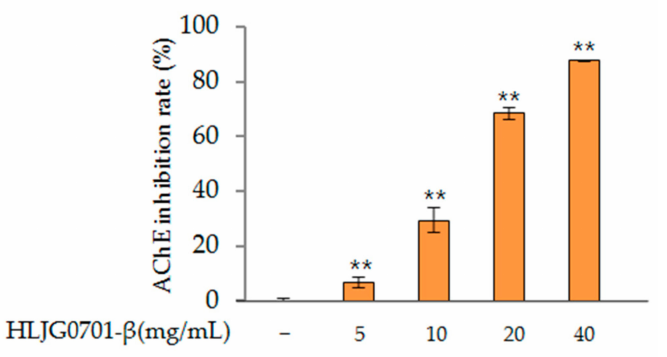
Figure 2. AChE inhibition rates of HLJG0701- β . Data are presented as mean ± standard deviation. Error bar: standard deviation; **, significant difference compared with control by one-way ANOVA, p <